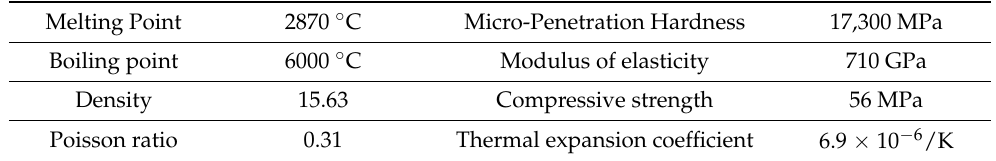
Figure 17. Trajectory diagram of sediment particles.